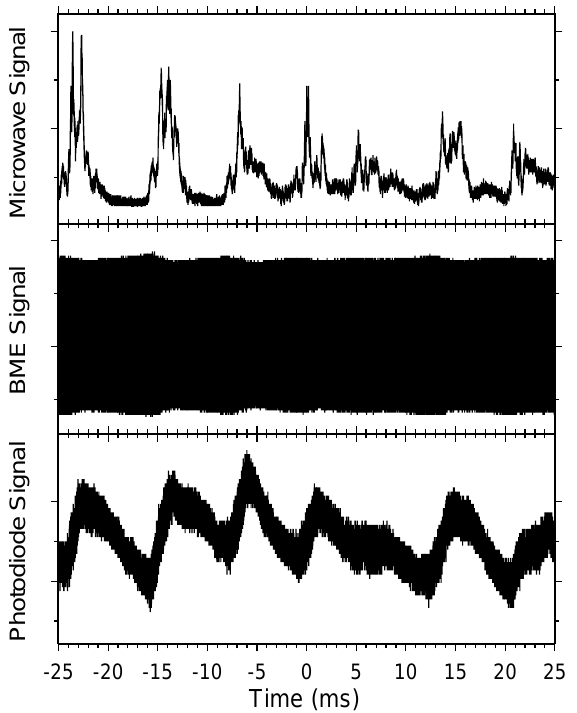
FIG. 4. Top: microwave signal; middle: beam monitor electrode signal; bottom: photodiode signal. The data were collected at E 0 (cid:1) 183.1 MeV, I B (cid:1) 105.5 mA, V rf (cid:1) 10.9 kV, and f rf (cid:1) 67.0 ± . At this lower energy the microwave bursts are not as regular in time and shape. Their behavior is rather chaotic. Surprising here is that the bursts do not seem to be connected with strong changes in bunch length; however, they are correlated with dipole and quadrupole modes in the BME spectrum (not shown). The signal levels are omitted because they are not meaningful, since they depend strongly on the collection electronics.